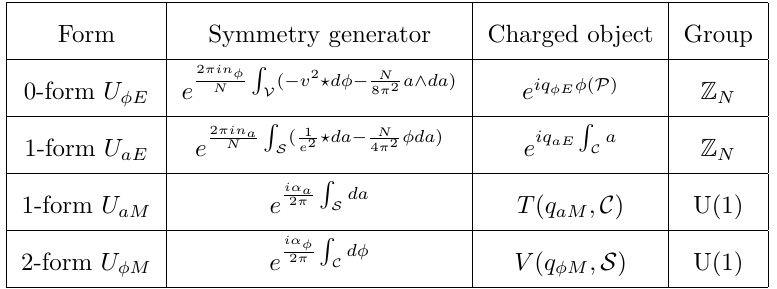
Table 1 . Higher-form symmetries of the massless axion